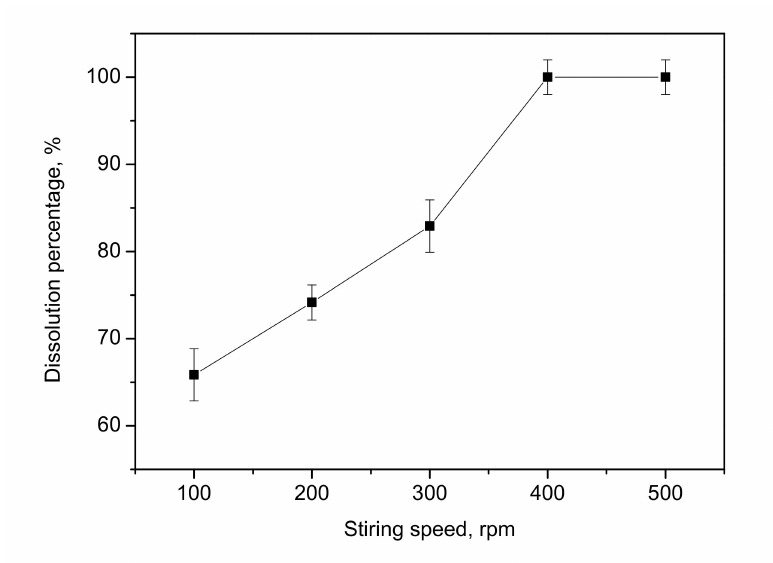
Figure 9. Effect of stirring speed on the dissolution of Pd. Conditions: TBP = 3 M; diluent: kerosene; Pd/TBP ratio =1.25 g/L; Pd/HCl ratio = 12.5 g/L; Pd/H 2 O 2 ratio = 10 g/L; 60 ◦ C, 60